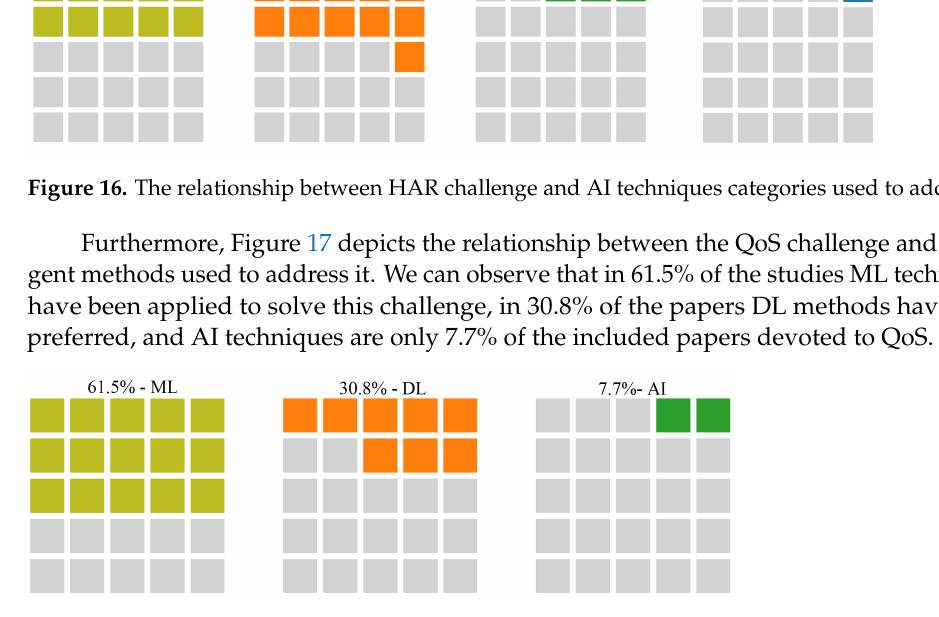
Figure 17. The relationship between QoS challenge and corresponding AI techniques categories used to deal with it.